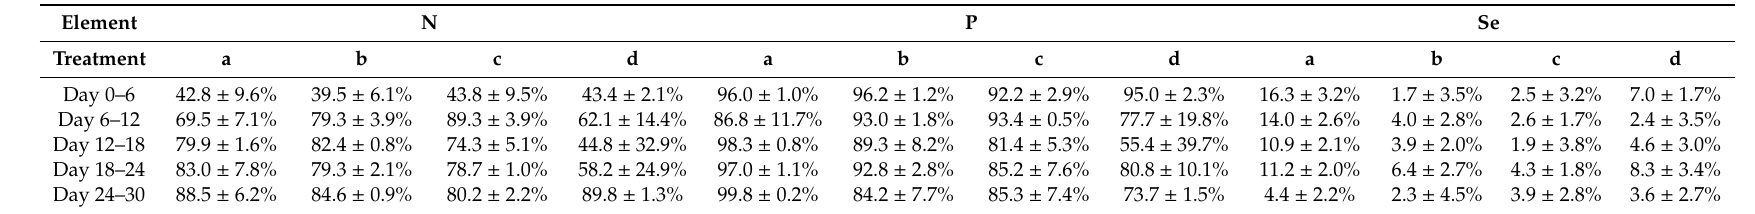
Table 2. The removal e ffi ciency of N, P, Se in the bioremediation test with di ff erent biofilm carriers.